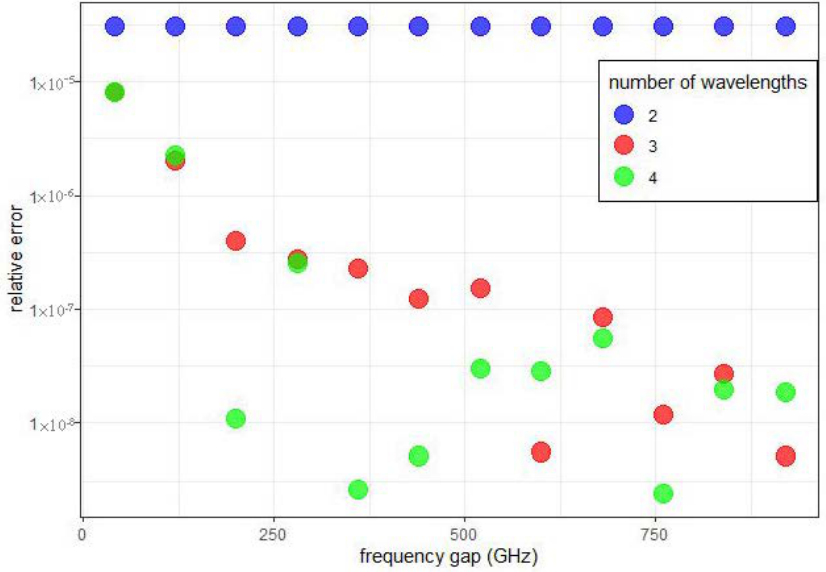
Figure A1. σ rel relative error (absolute value) vs. frequency gap via electro-optic modulator (central R ∗ wavelength 1.55 µ m). Different colors correspond to different number of frequencies used by the proposed approach to range estimation. It can be seen that for 3 and 4 (red and green colors) frequencies the method reaches good levels of sensitivity only for unfeasible high gap values, while for 2 frequencies only (blue color) the relative error never significantly declines in the interval considered, looking like a constant value in comparison to the other